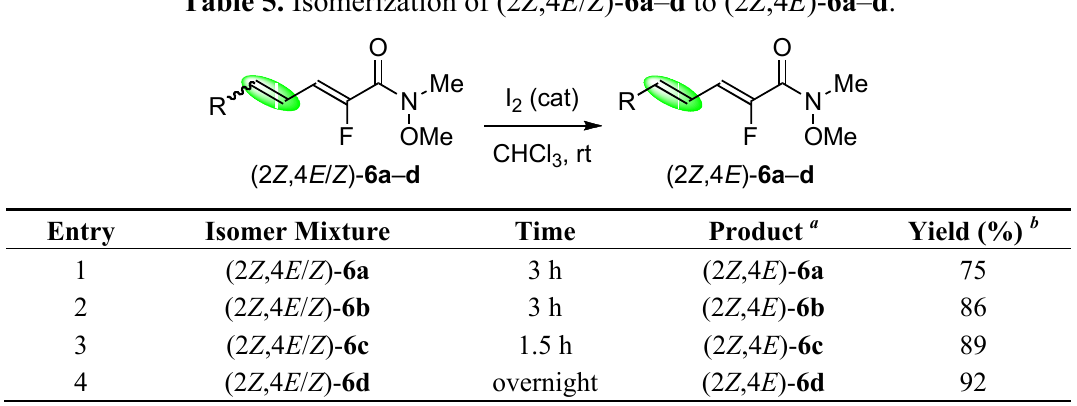
Table 5. Isomerization of (2 Z ,4 E / Z )- 6a – d to (2 Z ,4 E )- 6a – d